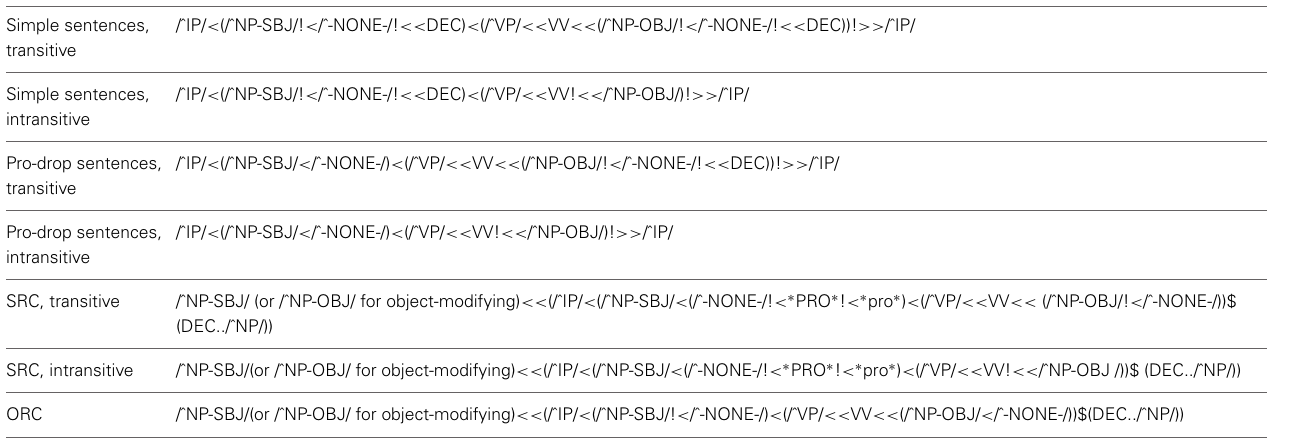
Table B1 | Tgrep2 search patterns for structures in Study